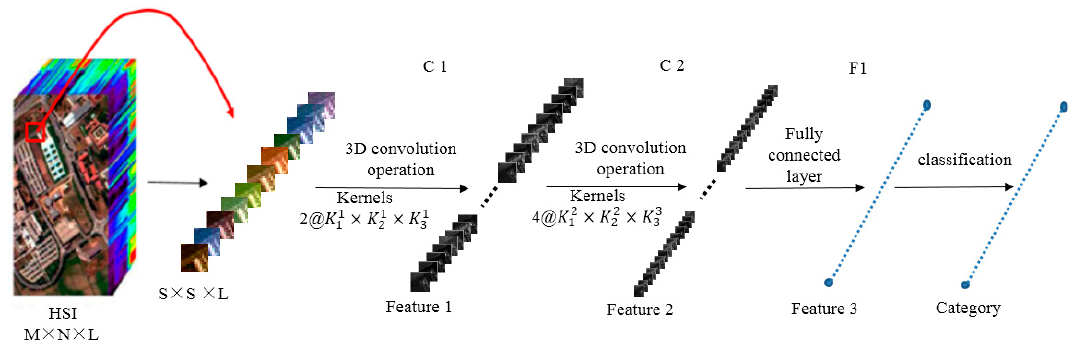
Figure 2. Illustration of the three-dimensional convolutional neural network (3D-CNN)-based hyperspectral imagery (HSI) classification framework.